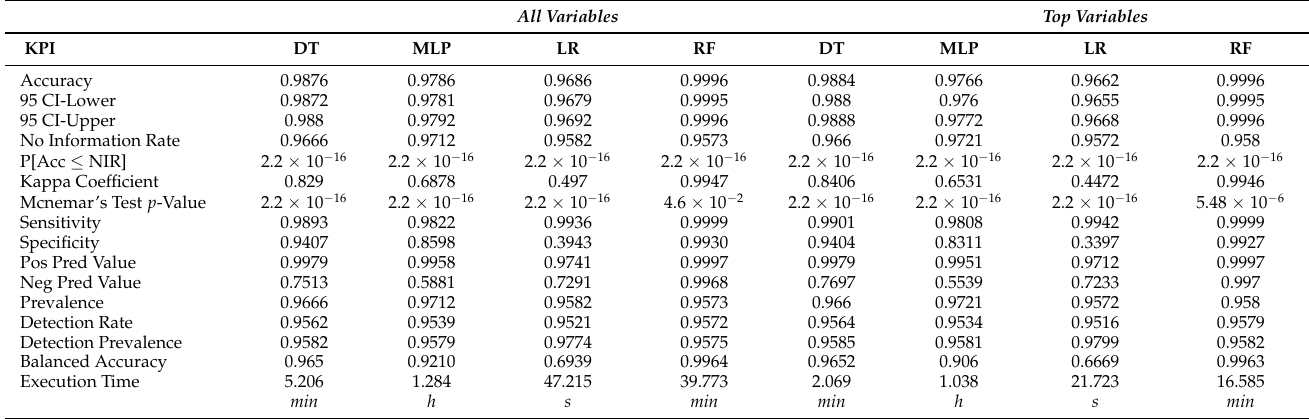
Table 7. Methods Comparison by Key Performance Indicators: Alarm Prediction in 12 h.